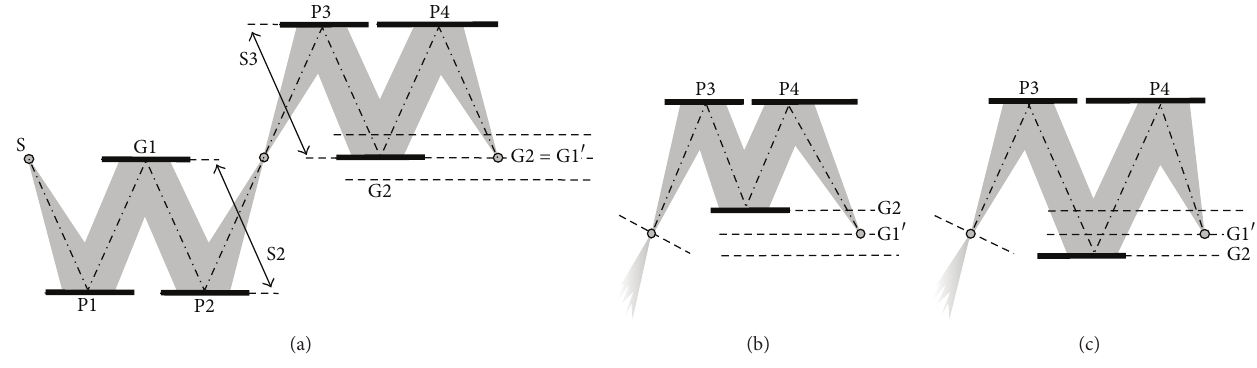
Figure 6: Operation of the configuration with variable GDD: (a) GDD = 0; (b) GDD > 0; (c) GDD < 0.